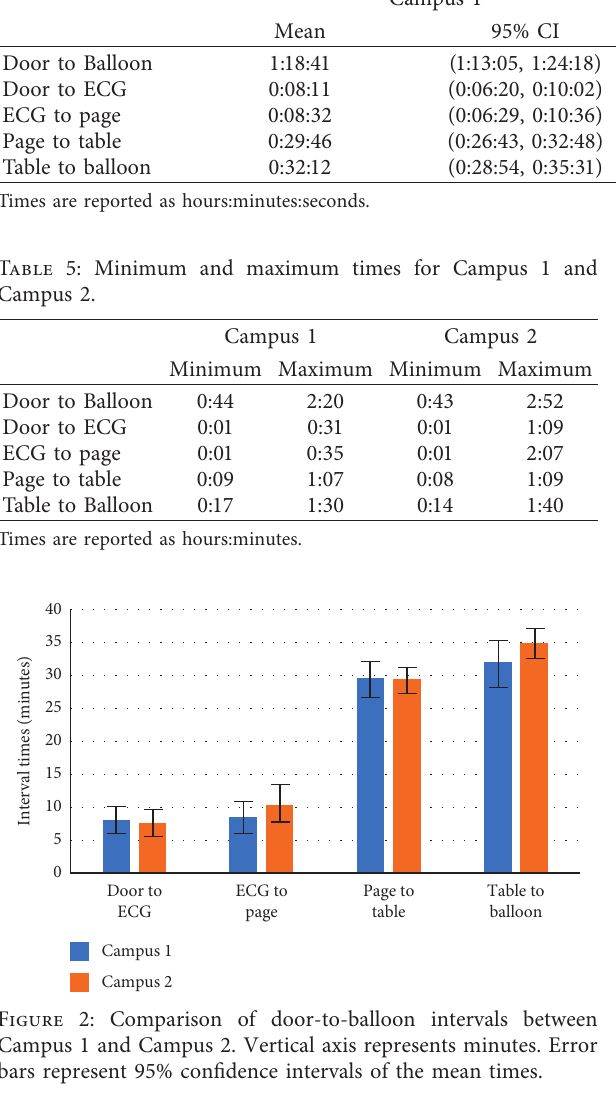
Figure 2: Comparison of door-to-balloon intervals between Campus 1 and Campus 2. Vertical axis represents minutes. Error bars represent 95% confidence intervals of the mean